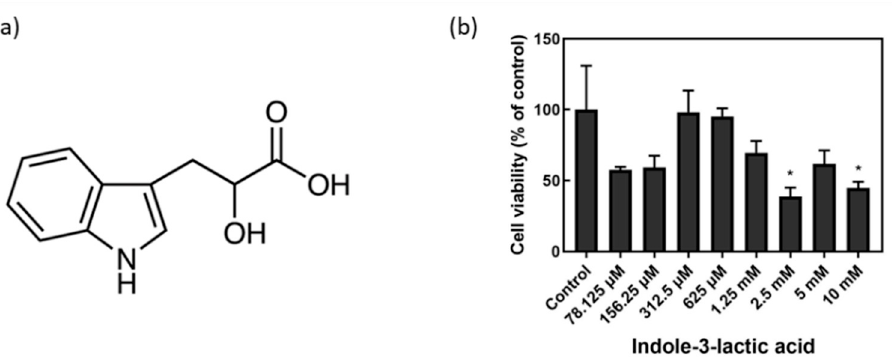
Figure 1. Indole-3-lactic acid (I3LA) structure and MTT assay results. ( a ) Formula for I3LA (molecular weight is 205.21 g/M; empirical formula (hill notation: C11H11NO3). ( b ) Calculated concentration versus cell viability data for I3LA toxicity in keratinocytes using MTT assay (50% or more cell viability was assumed to be safe). ( n = 3; * p < 0.05; control group vs. several experimental groups.)